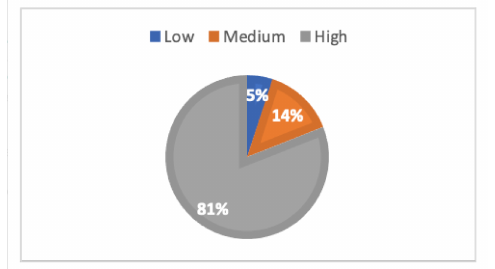
Figure 8. Perception of the tourism potential of las M é dulas. Source: Author’s